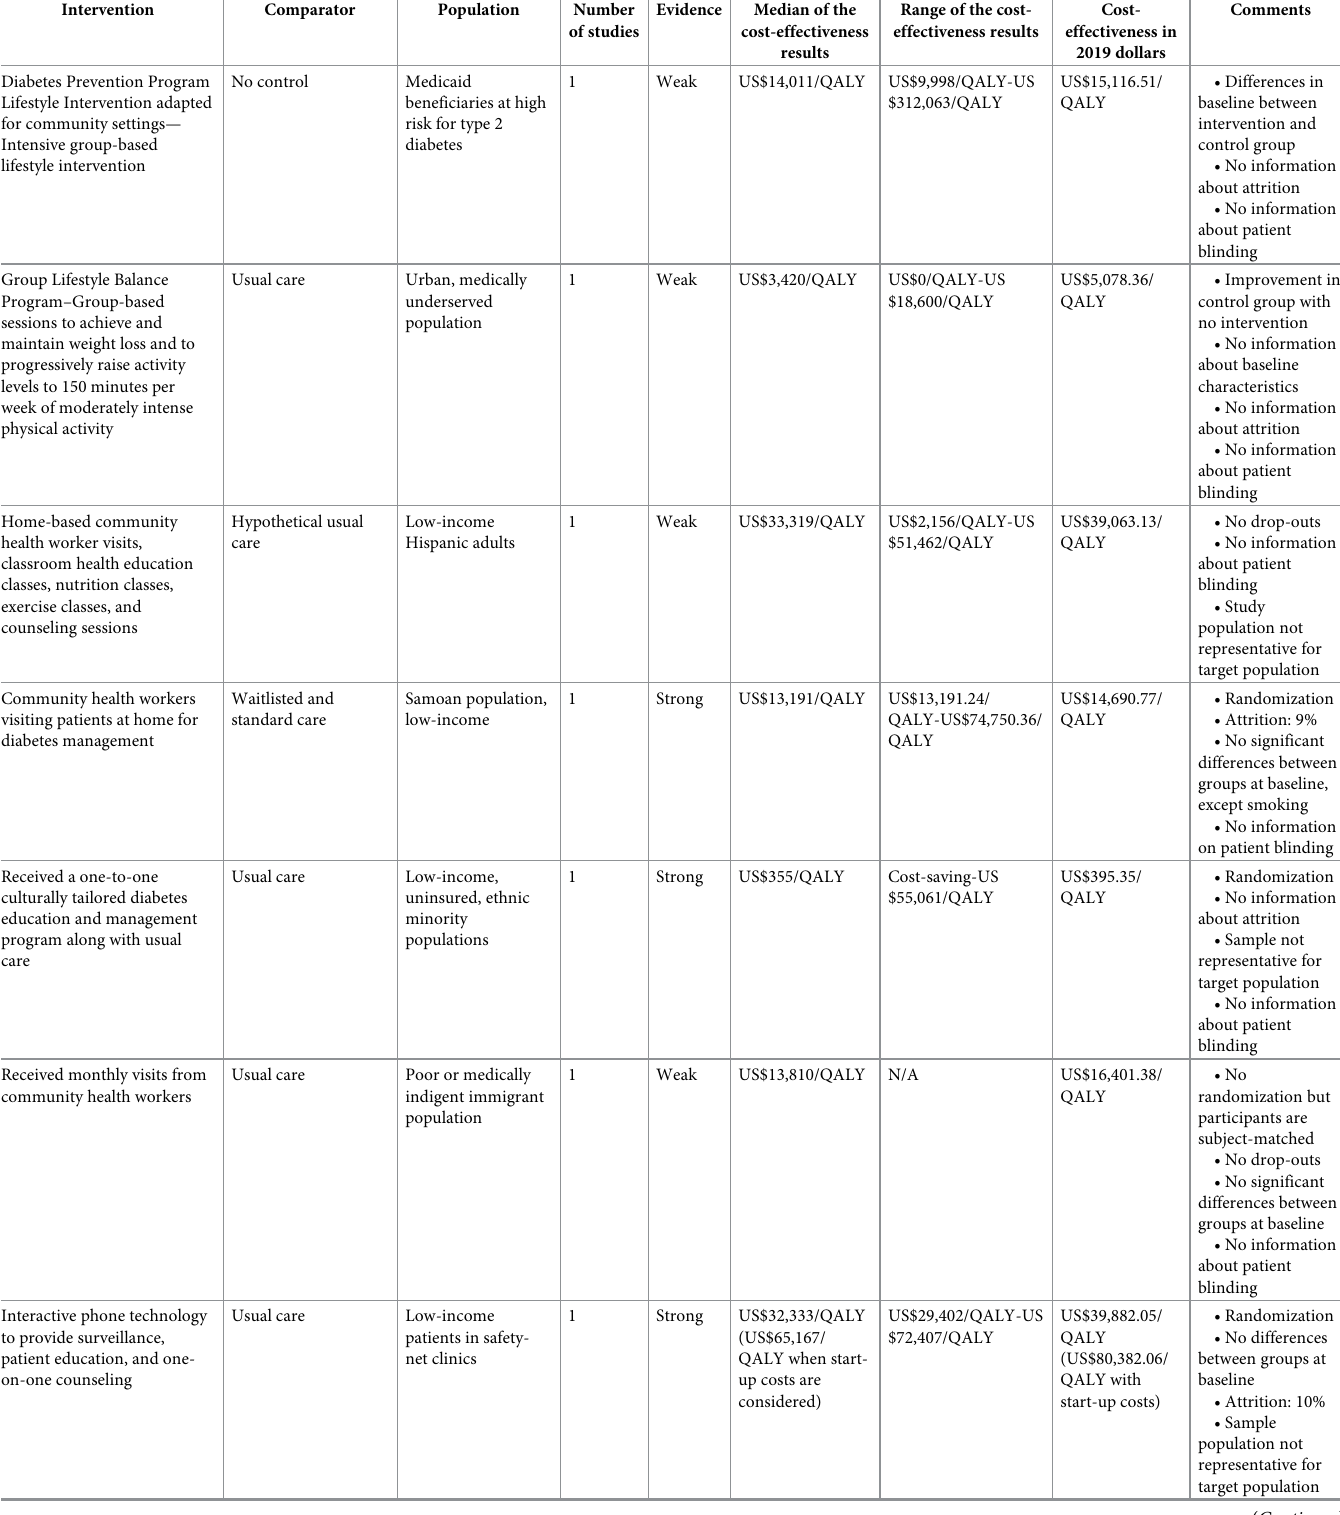
Table 3. Summary of the cost-effectiveness results according to intervention.